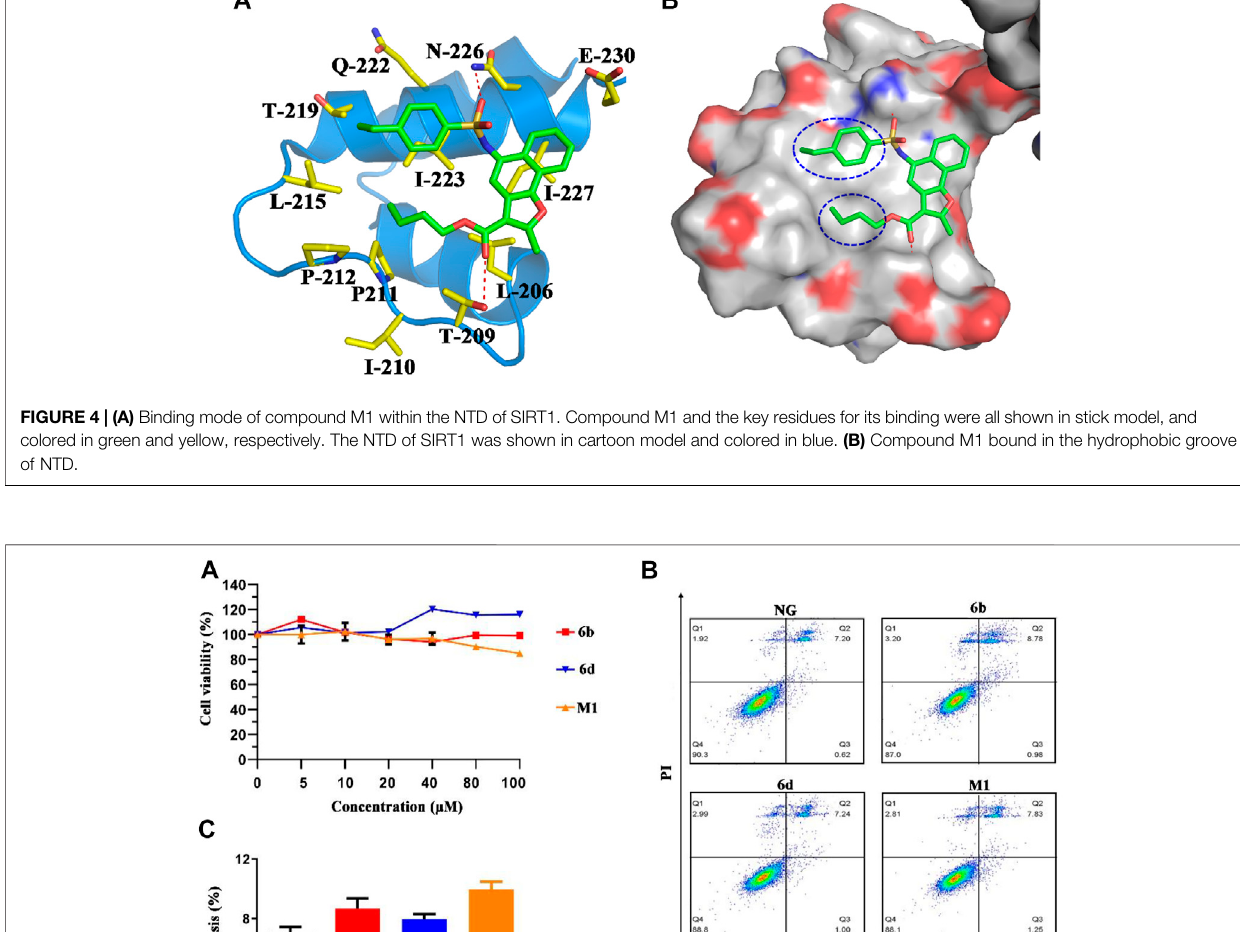
Frontiers in Pharmacology |